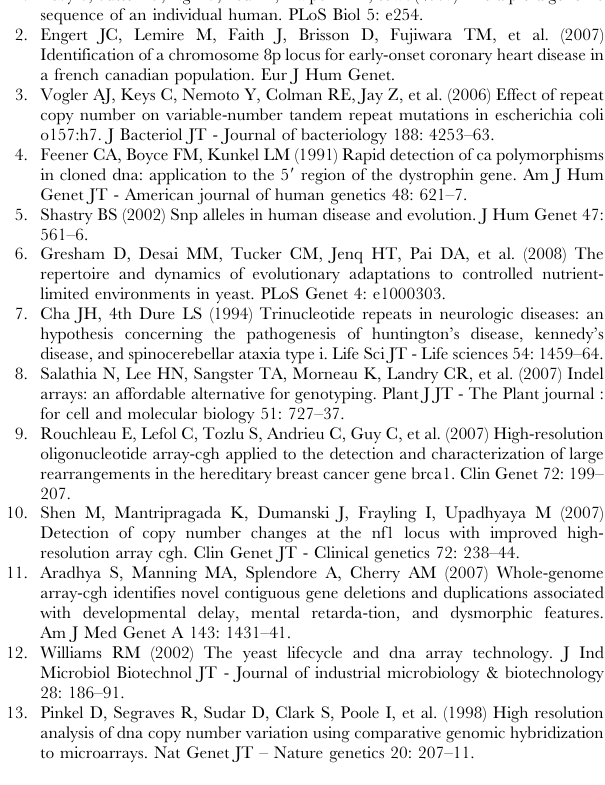
Figure 6. Two examples of Ruler Array data (S288c in red, S 1278b in green) and genomic sequence demonstrating the impact of AT repeat length changes on polymerase processivity. The S 1278b intensities fall suddenly over the repeat. Both examples were sequenced in both directions to confirm the repeat length difference, 14 bp in the upper example and 2 bp in the